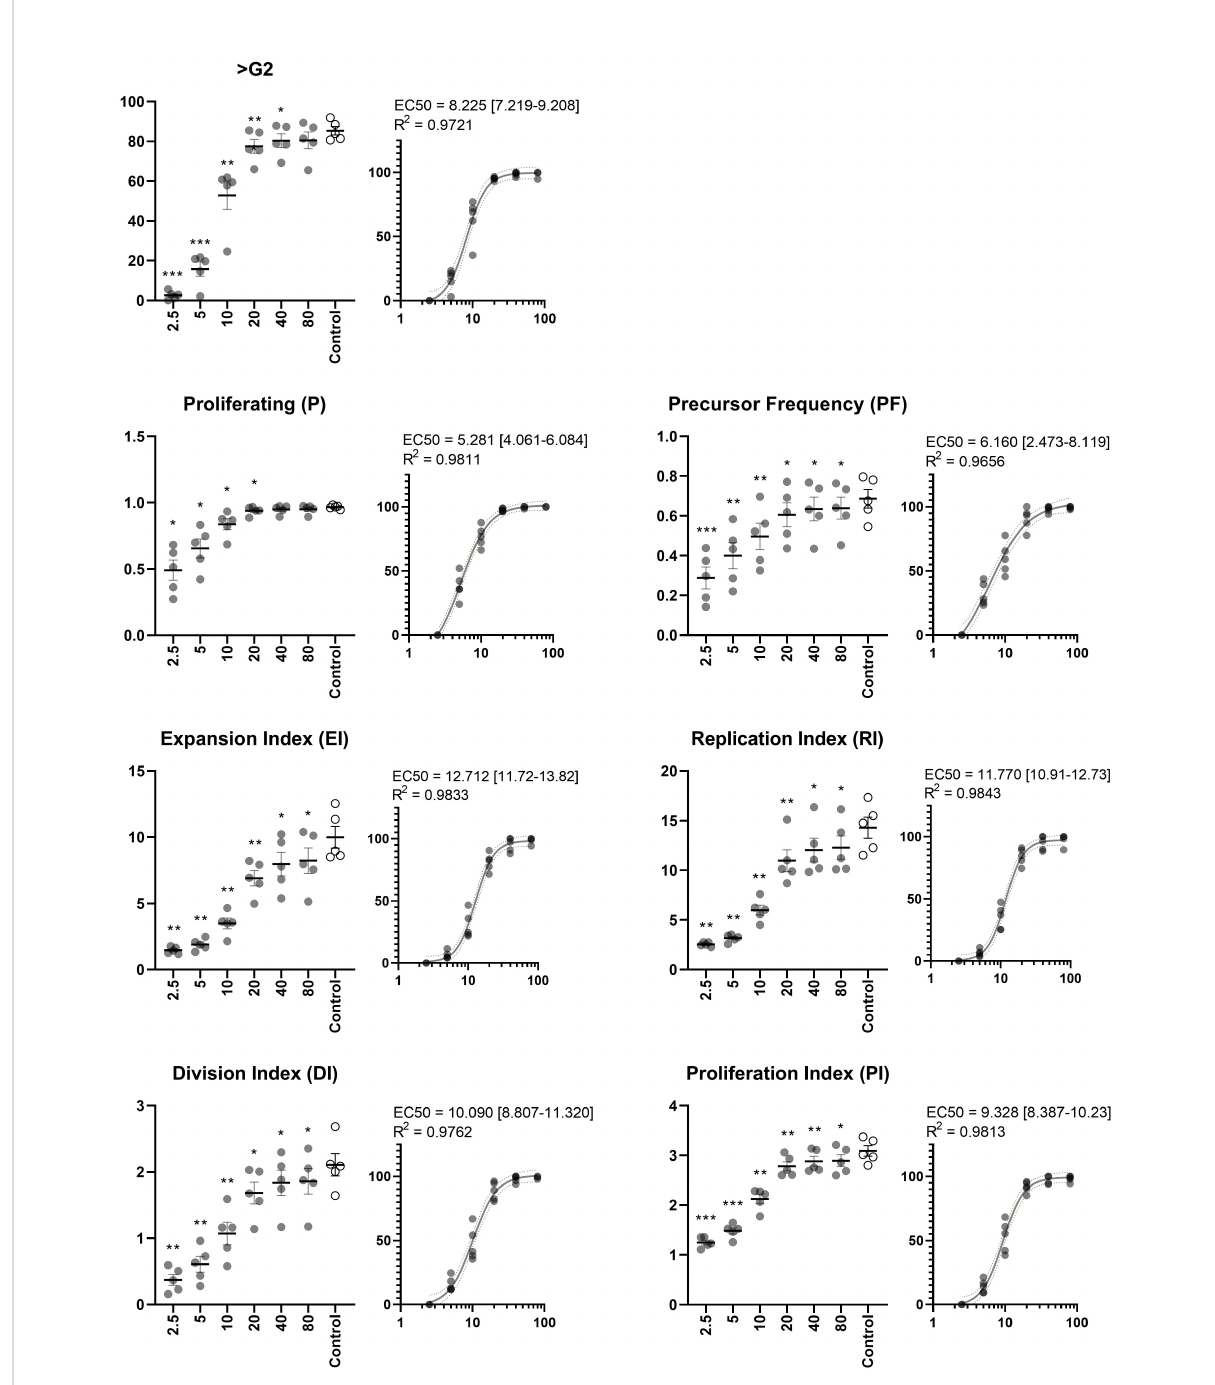
FIGURE 6 Dose-response of ASC. Percentage of proliferating lymphocytes by simple analysis (>G2) and extended analysis (P, PF, EI, RI, DI, and PI). ASC were included in concentrations (ASC : PBMC ratios) ranging from 1:2.5 to 1:80. EC 50 was calculated to determine the ratio at which half maximum effect occurs. The PHA-stimulated control does not contain ASC Repeated-measures ANOVA. Signi fi cant differences from the PHA- stimulated control are indicated at levels of *) p < 0.05; **) p < 0.01; ***) p < 0.001. EC 50 is reported with 95% con fi dence interval in square brackets and goodness of fi t (R 2 ) inserted above dose-response curves. n=5. PHA, Phytohemagglutinin; EC 50 , half maximal effective concentration; ASC, Adipose tissue-derived Stromal Cells; PBMC, Peripheral Blood Mononuclear